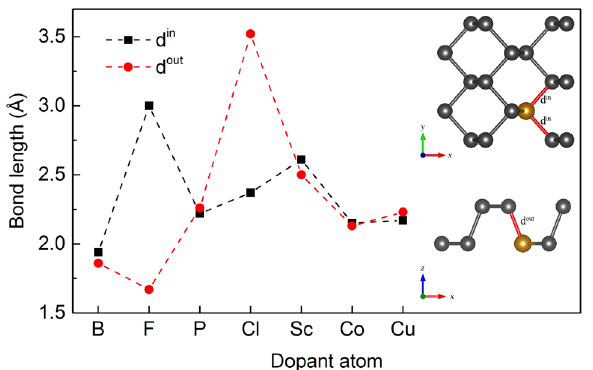
in out ) and out of the xy plane ( d ) for